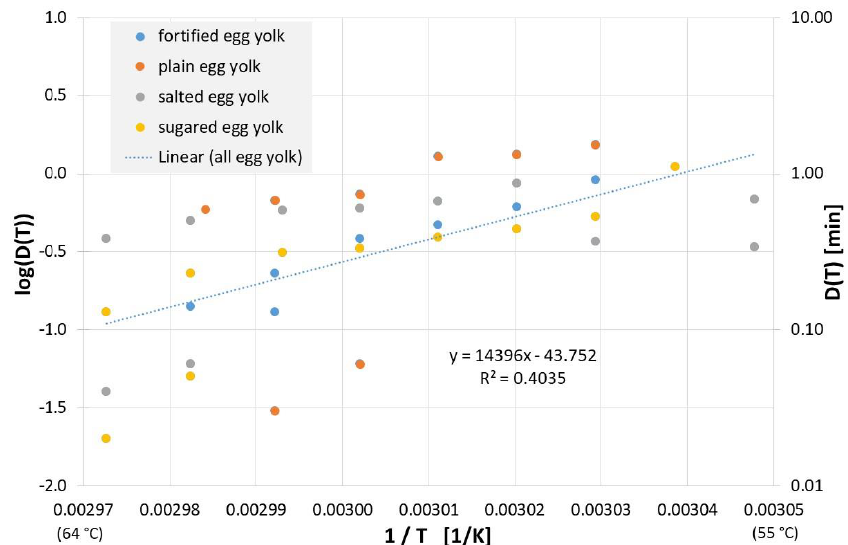
Figure 9. Correlation between 1/T and log(D(T)) for all published influenza virus thermal inactivation data in plain, sugared, salted and fortified egg yolk along with the linear regression curve. For better understanding, D(T) is also given on the right Y-axis in a logarithmic